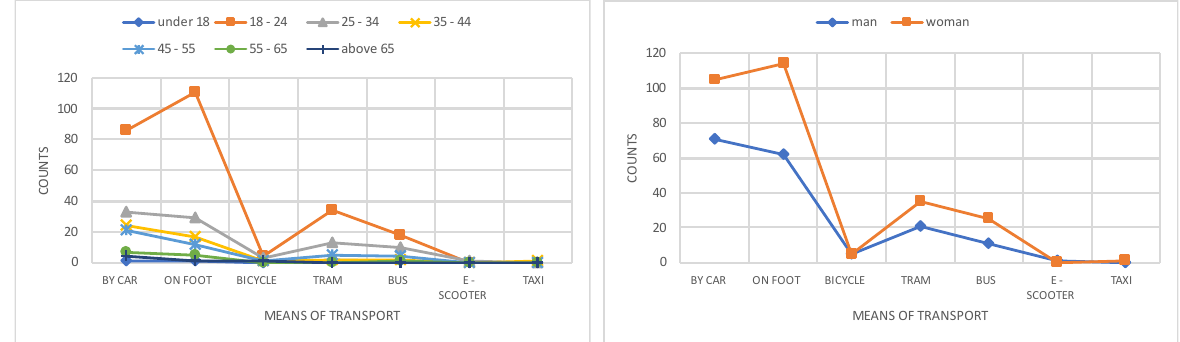
Figure 6. The choice of individual means of transport in the home – shopping direction for selected groups.